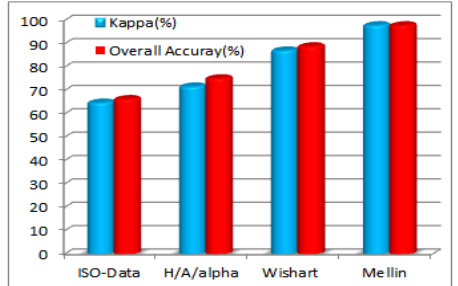
Figure 8. The matrix log-cumulant diagrams.